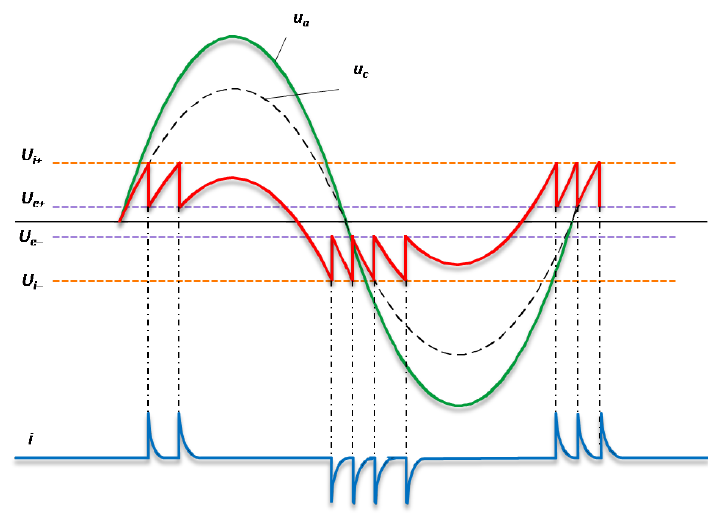
Figure 2. Generation of PD current pulses.